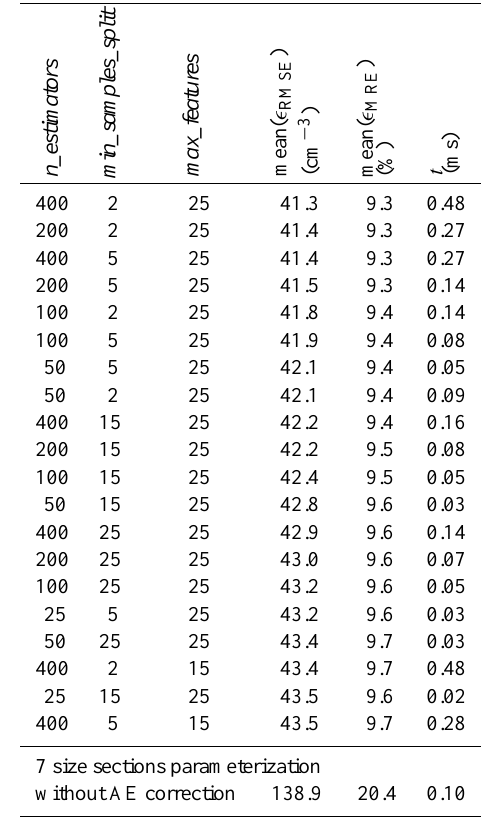
Table 6. Training parameters and results of the AE correction in the case of 4 size sections parameterization: number of trees in the RF model n_estimators , the RF training parameters min_samples_split and max_features , the mean values of root-mean-squared errors (cid:15) RMSE (RMSE) and mean relative errors (cid:15) MRE (MRE), and the av- erage time used for evaluating the RF model t .